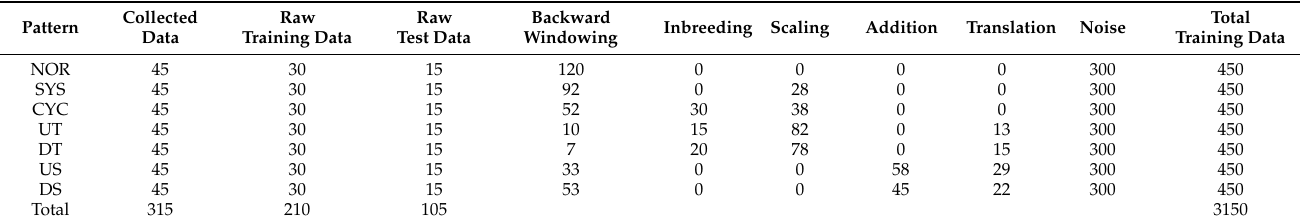
Table 3. Number of samples of each pattern before and after data